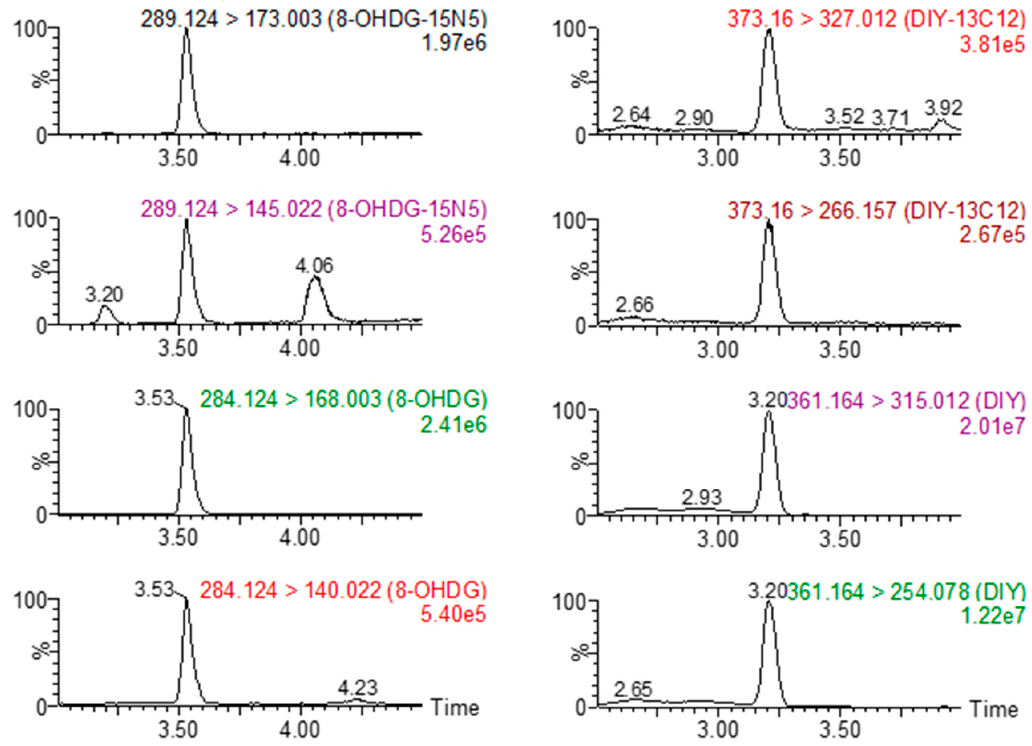
Figure 2. SRM chromatograms of 8OHDG, 15 N 5 -8OHDG, DIY, and 13 C 12 -DIY in a fortified fish liver sample.